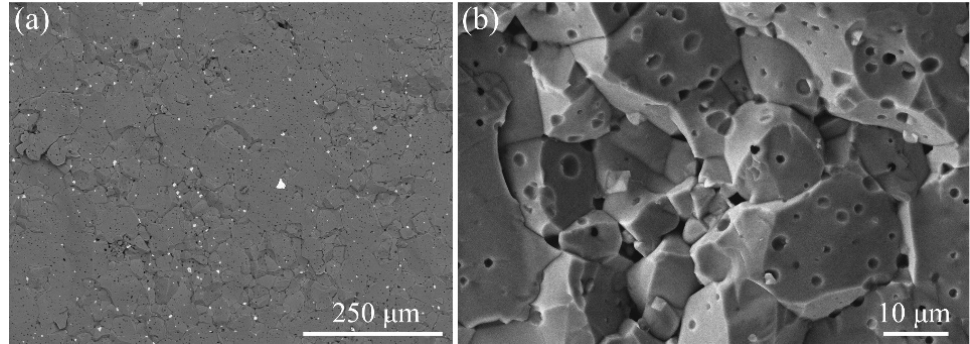
Figure 4. ( a ) Fracture surface of the joint after shear test; ( b ) high magnification morphology of the fracture surface.